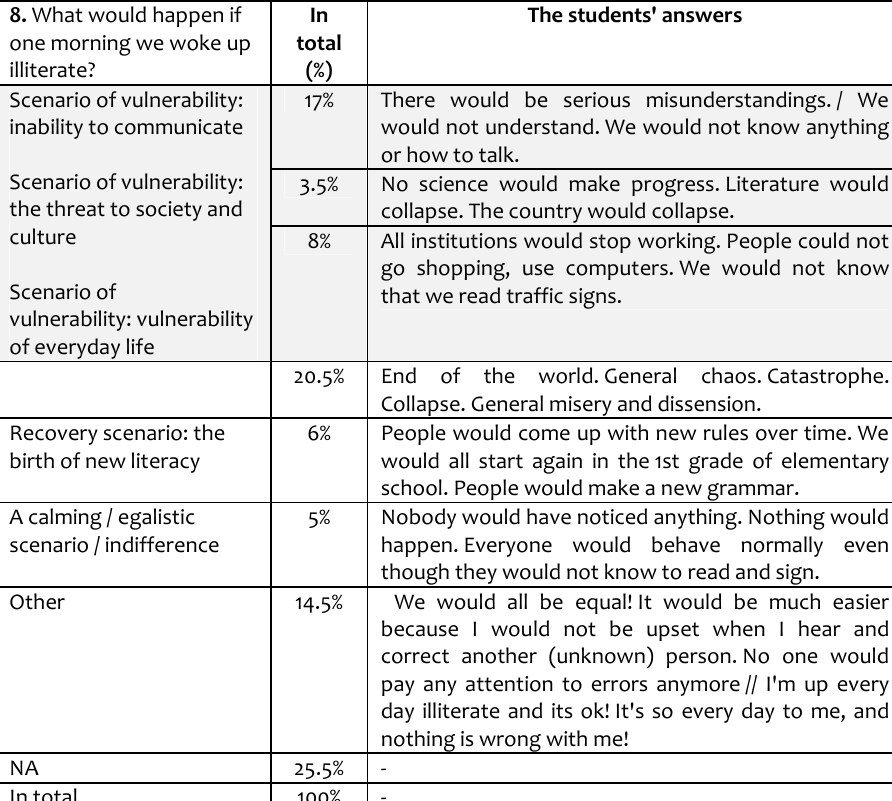
Table 9. Typology and percentage representation of the answer to the question: What would happen if we woke up one morning as